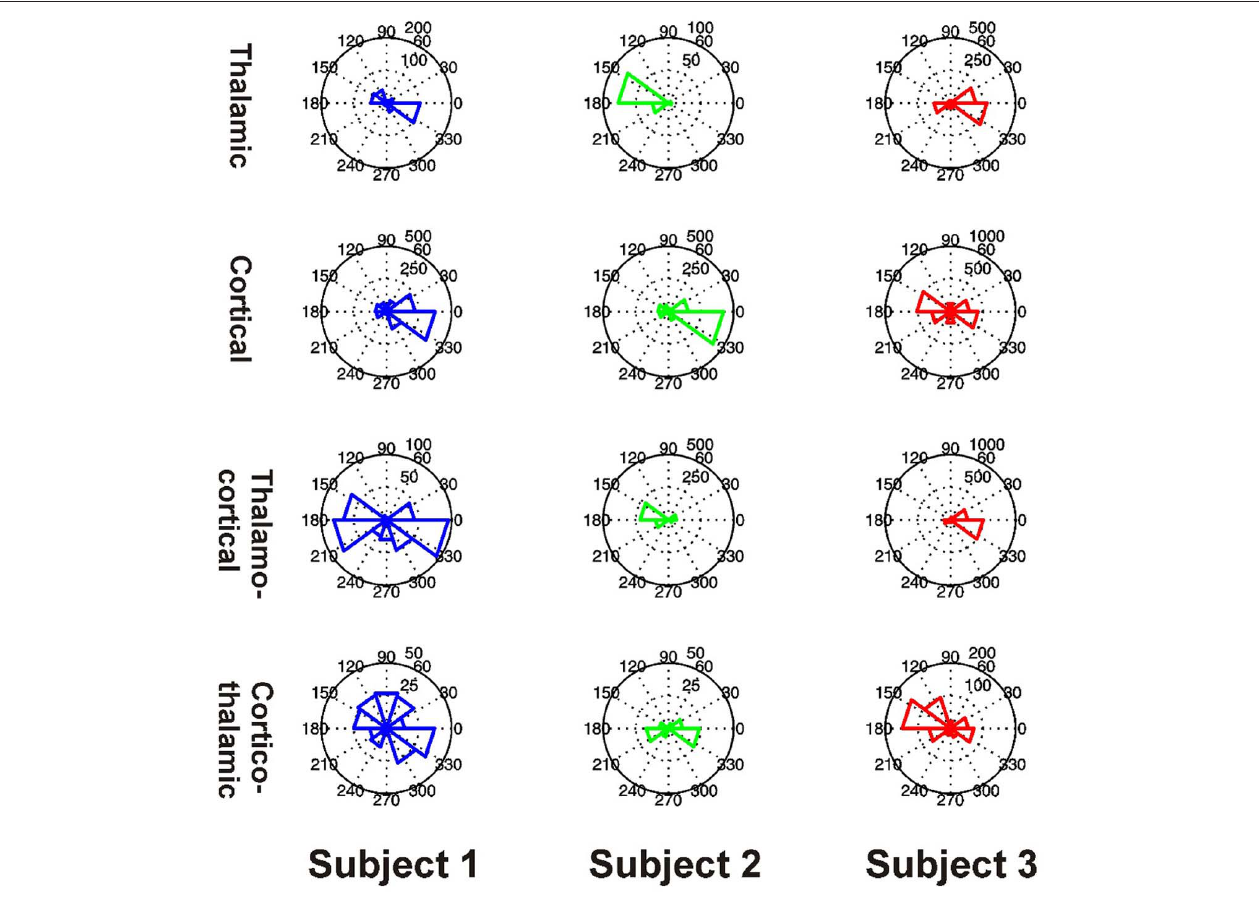
FIGURE 10 | Distributions of preferred PAC phases for FBPs which showed significant coupling in Subjects 1 (blue, left), 2 (green, middle), and 3 (red, right). PAC types are shown separately as thalamic (top row), cortical (second row), thalamo-cortical (third row), and cortico-thalamic (fourth row) coupling.